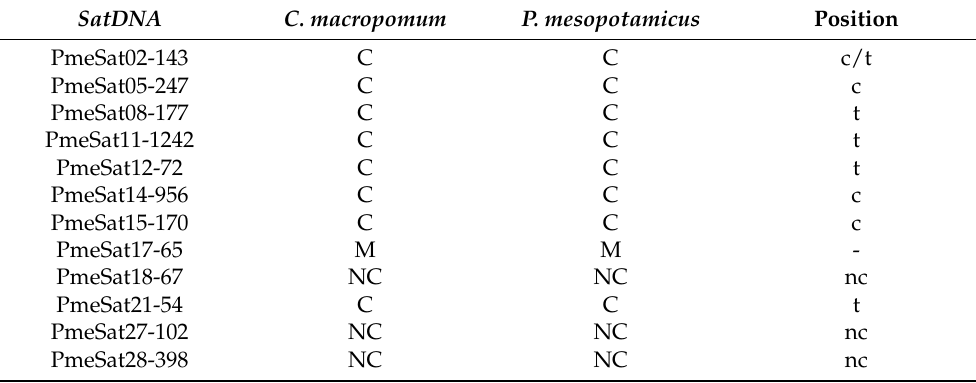
Table 5. Fish patterns of SatDNA families conserved between P. mesopotamicus and C. macropomum . The patterns of satDNAs were classified as clustered (C), non-clustered (NC) and mixed (M). Position was catalogued as pericentromeric (c) and telomeric (t). SatDNA C. macropomum P. mesopotamicus Position